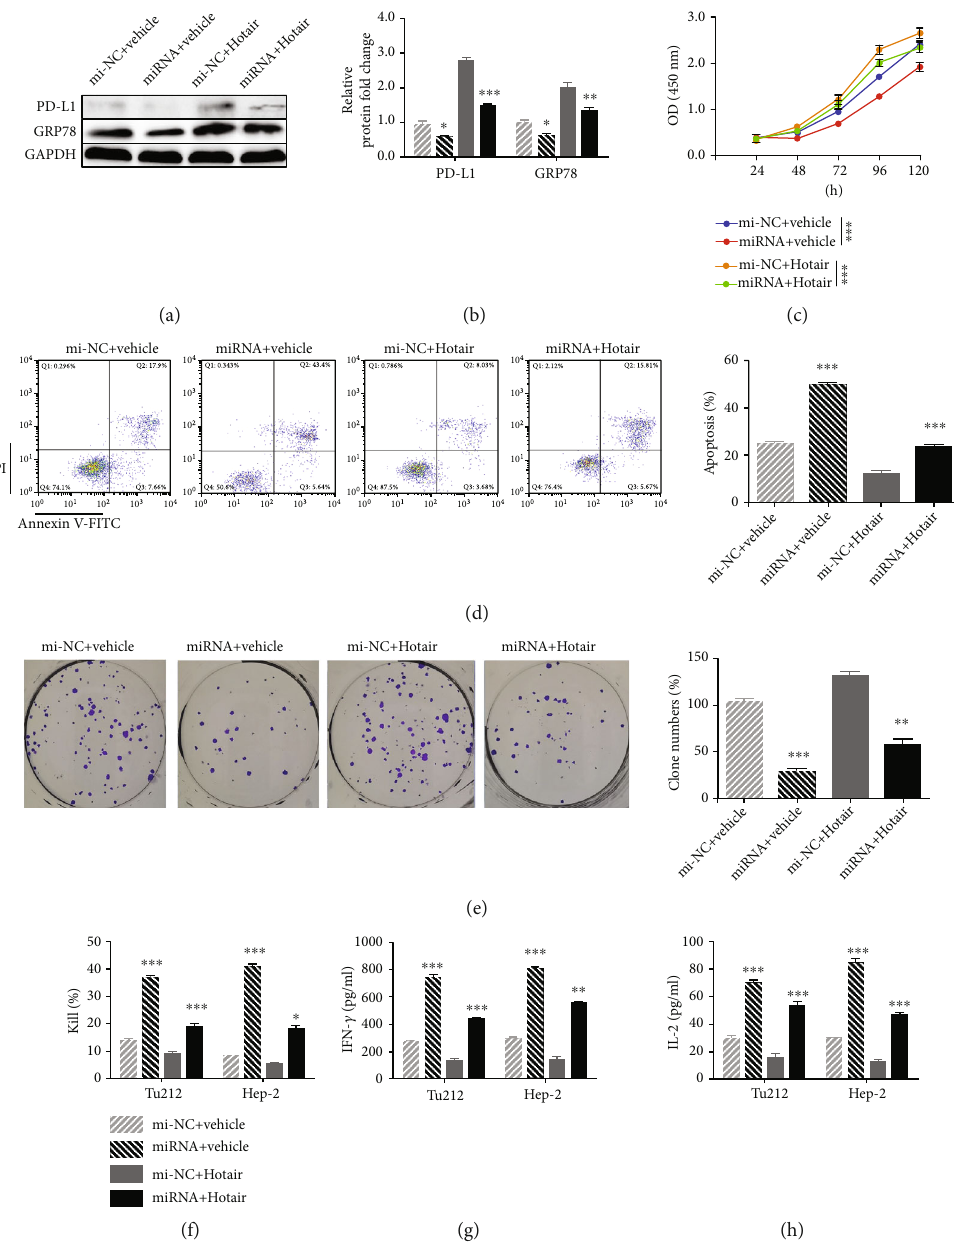
Figure 3: Hotair promotes the expression of GRP78 and PD-L1, mediates the proliferation, and helps to regulate the T cell-mediated immune responses in Tu212 and Hep-2 cells. Western blot analysis of GRP78 and PD-L1 after mi-NC or has-miR-30a-5p and vehicle or Hotair transfection in Hep-2 cells (a). The relative expression level of GRP78 and PD-L1 in Hep-2 cells (b). (c – e) The cell viability, apoptosis, and colony formation after mi-NC or has-miR-30a-5p and vehicle or Hotair transfection in Hep-2 cells. (f – h) T cell killing assay of target Tu212 and Hep-2 cells cocultured with PBMC, and ELISA detects the concentration of cytokines (g) IFN- γ and (h) IL-2. The targeted Tu212 and Hep-2 cells after 24h transfected with mi-NC or has-miR-30a-5p and vehicle or Hotair were cocultured with PBMC, and the cytotoxicity was measured by the LDH release assay. Data are mean ± SD of at least three independent experiments; ∗ p < 0 : 05 ; ∗∗ p < 0 : 01 ; ∗∗∗ p < 0 : 001